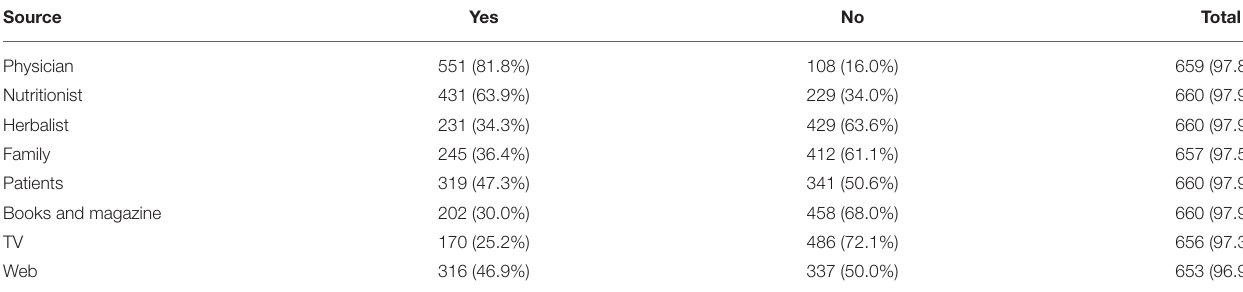
TABLE 6 | Participants perception and beliefs about their preferred source of information to treat psychological disorders by medicinal plants.